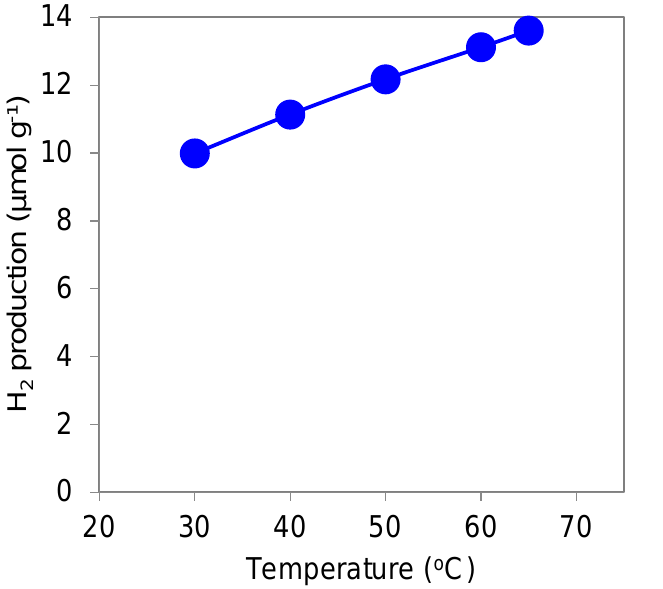
Figure 5. Effect of temperature. TiO 2 , 50 mg; Rh, 1.25 ppm; reaction time, 3 h; formic acid concentra- tion, 1